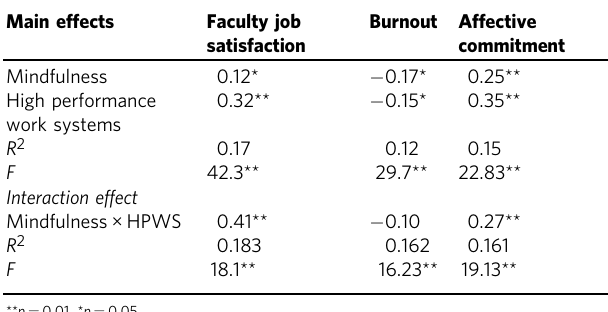
Table 5 Results of moderating effects of